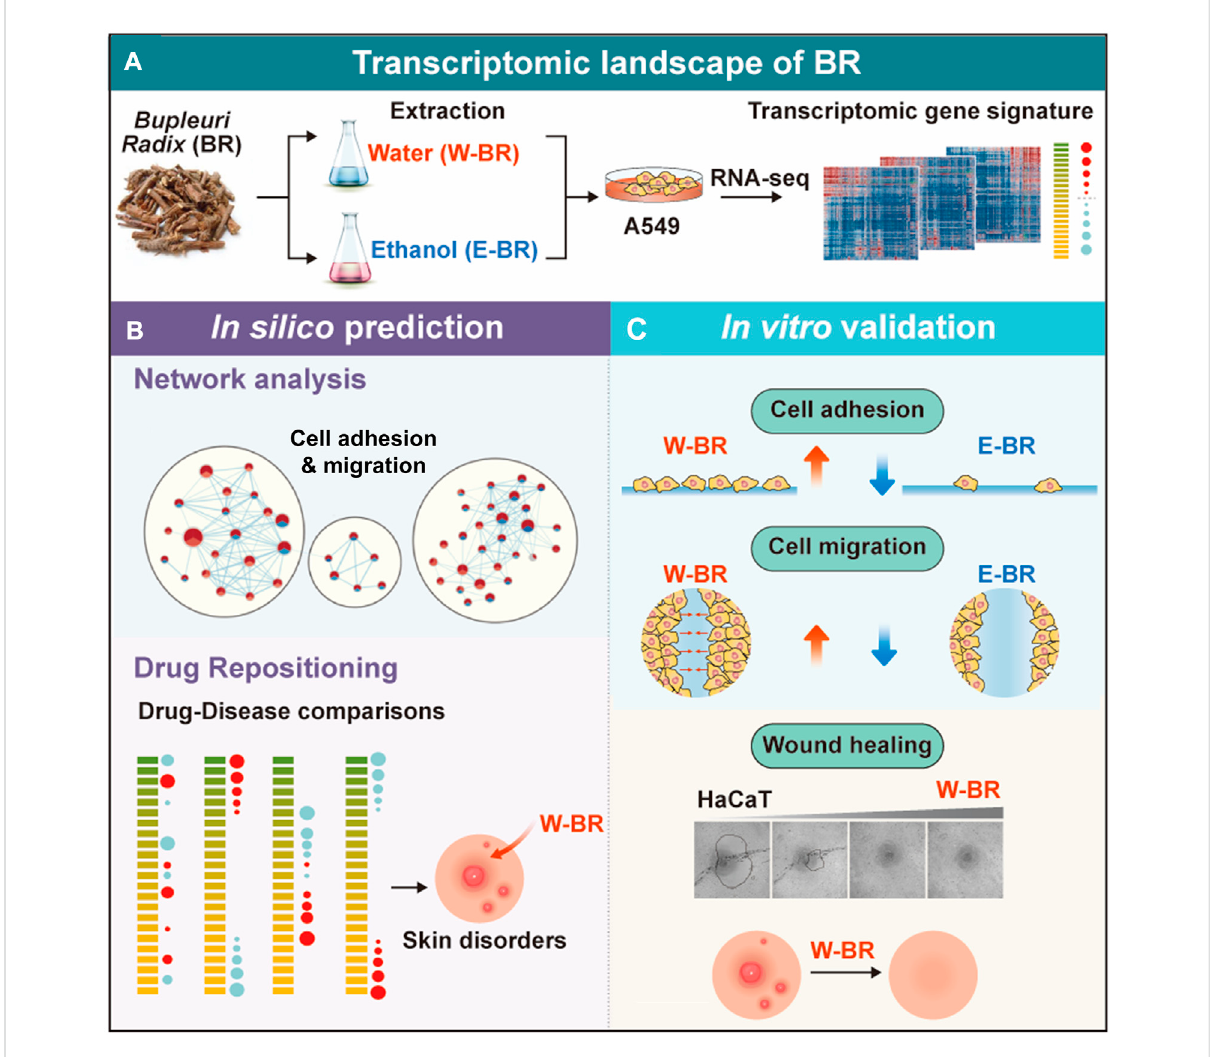
FIGURE 6 Summaryofmethodsand fi ndingsofthestudy. (A) Transcriptomedatainducedbytreatmentofbupleuriradix(BR)extractsandtheiringredients were generated using RNA-seq. (B) Systematic transcriptomic analysis revealed increased cell adhesion and migration in BR ethanol extract (E-BR) butnotinBRwaterextract(W-BR).Furtherdrug-diseasecomparisonsuggestedindicationsforskindisorders. (C) Molecularexperimentvalidatedthe identi fi ed molecular mechanisms of W-BR and E-BR. The wound healing effect of W-BR was con fi rmed in skin cells. GOBP: Gene Ontology Biological Processes; REAC: Reactome; SS: